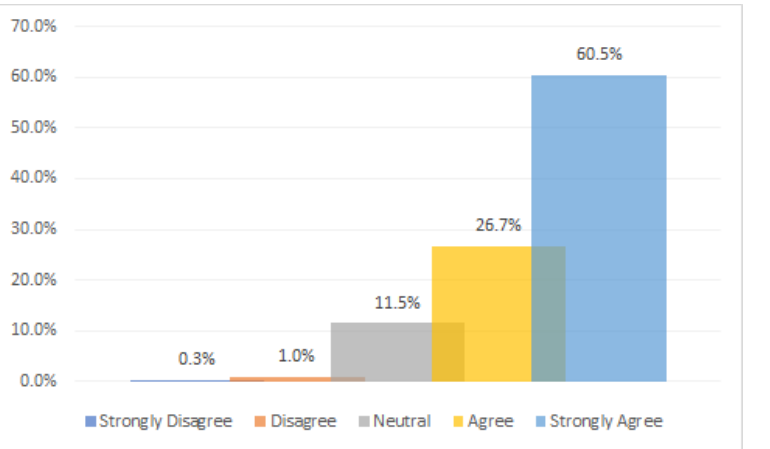
Figure 7. Answers to a Likert five-point scale to the question: Do you think storytelling has helped to enhance motivation?